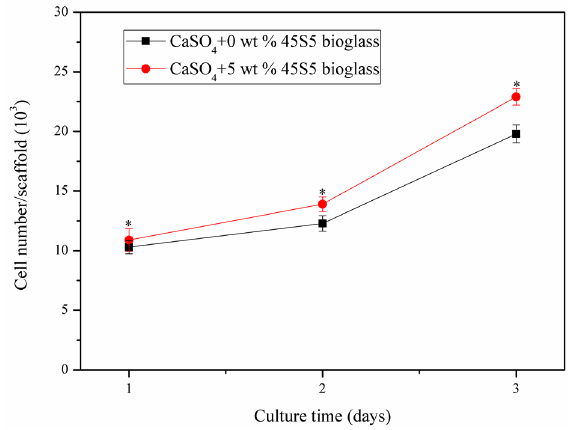
Figure 13. Microculture tetrazolium test (MTT) assay for proliferation of MG-63 cells on the scaffolds. Statistically significant difference (* p < 0.05) from the scaffolds without bioglass.